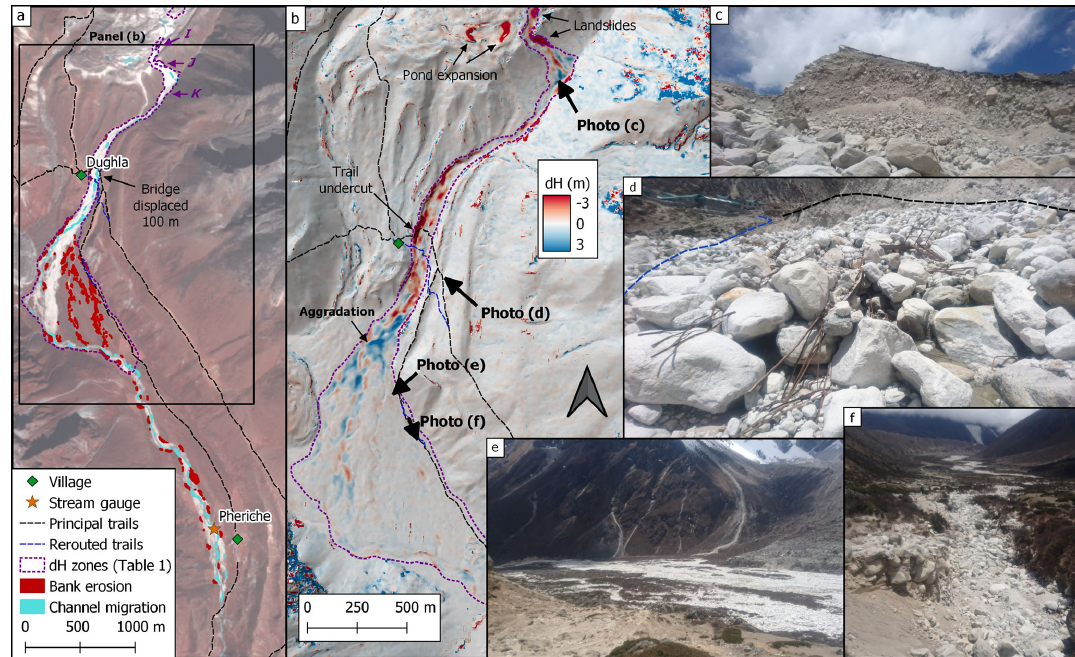
Figure 6. Flood-related geomorphic evidence down-valley of Khumbu Glacier. Extensive changes in vegetation cover due to bank erosion and migration of the stream channel 4km downstream to Pheriche (a) . Surface lowering associated with fluvial erosion and aggradation in the Khumbu proglacial system, and locations of selected photos (b) . A fresh landslide scarp (Zone J) directly below the Khumbu outlet (c) . Remnants of a pedestrian bridge destroyed, carried 100m downstream, and buried by the outburst, also indicating the route of the trail before and after the outburst, with Dughla in the background (d) . The Khumbu outwash plain in May 2018, showing widespread fluvially reworked debris (e) . A secondary channel used by the outburst flood, leading to > 1m incision (f) . Background in (a) is a RapidEye false-colour composite from November 2016 and in (b) is the hillshade derived from the March 2017 Pleiades